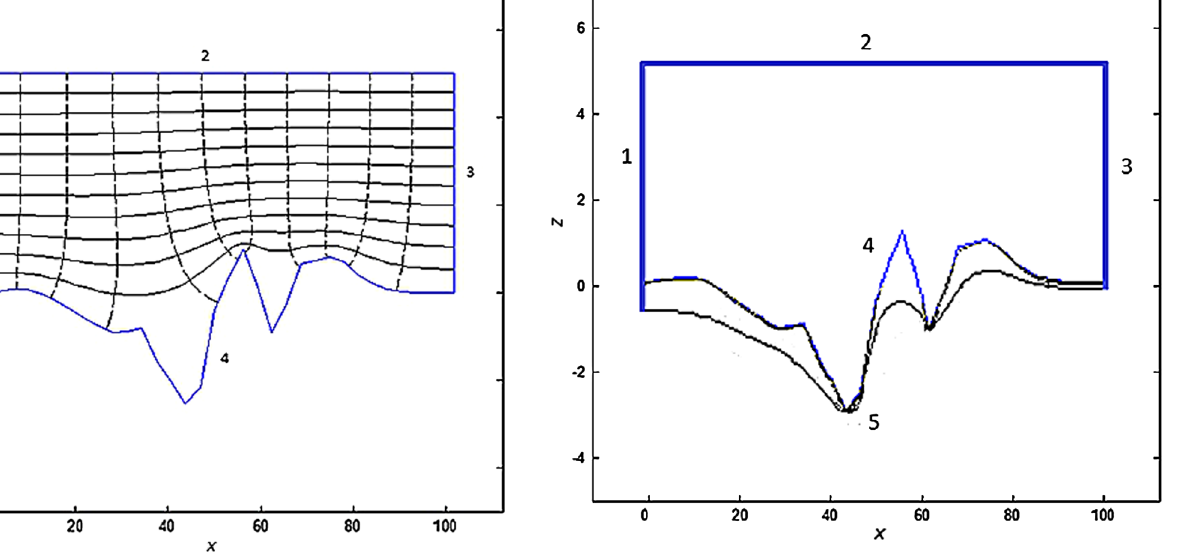
FIG. 3. Electromagnetic equipotential contours by conformal mapping calculation. The vertical dashed lines are E field lines, and horizontal lines are magnetic field lines. Unit: μ m.